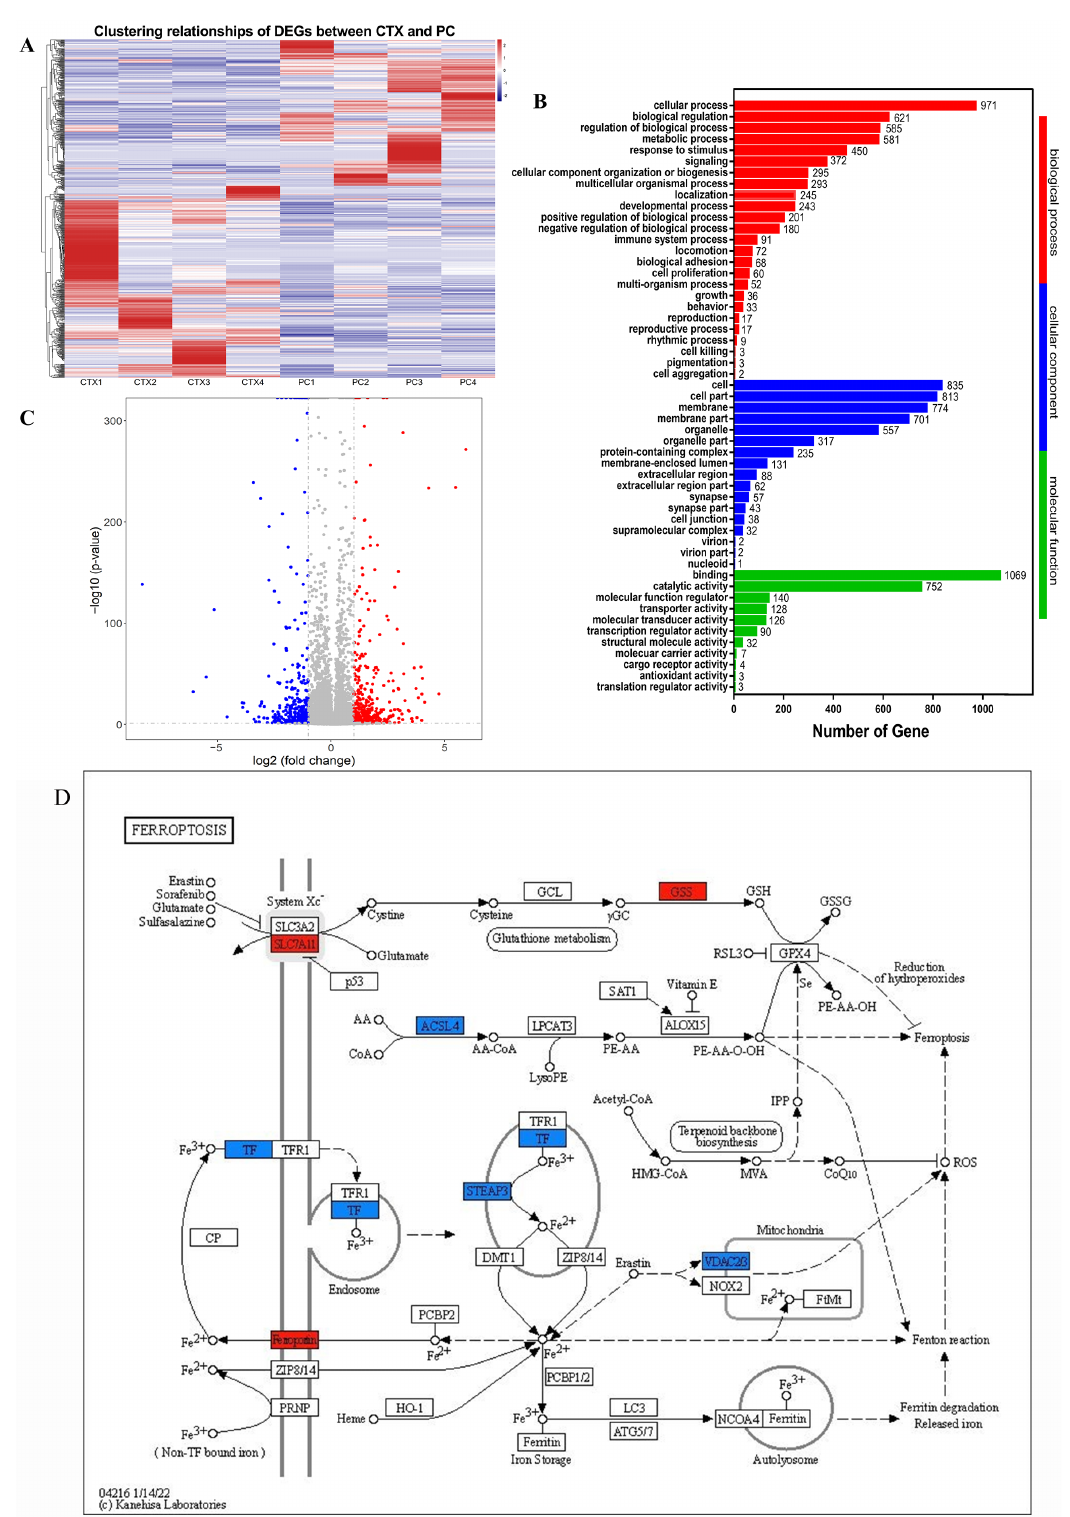
Figure 2. The ferroptosis pathway was involved in the thymus of CTX-treated goslings. ( A ) A heatmap of DEGs clustering relationship between CTX and PAMK + CTX groups; CTX indicates the CTX group; PC indicates PAMK + CTX group; ( B ) GO enrichment analysis of DEGs; ( C ) volcano plots visualizing DEGs with a cut-off criterion of excluding genes with 0 expression (red dots represent upregulated genes; blue dots represent downregulated genes); ( D ) Ferroptosis signaling pathways and associated genes (red indicates upregulated genes; blue indicates downregulated genes). n = 4.